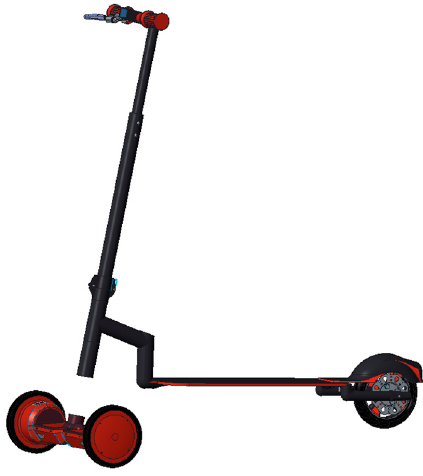
Figure 16. Final assembly.